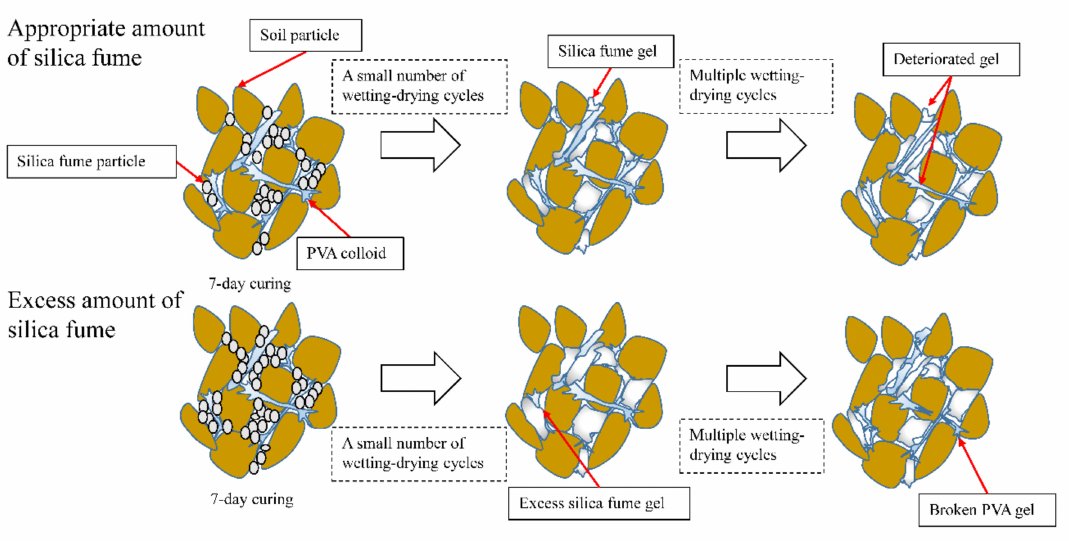
Figure 14. Schematic diagram of influence mechanism of wet–dry cycles on strength of composite- stabilized